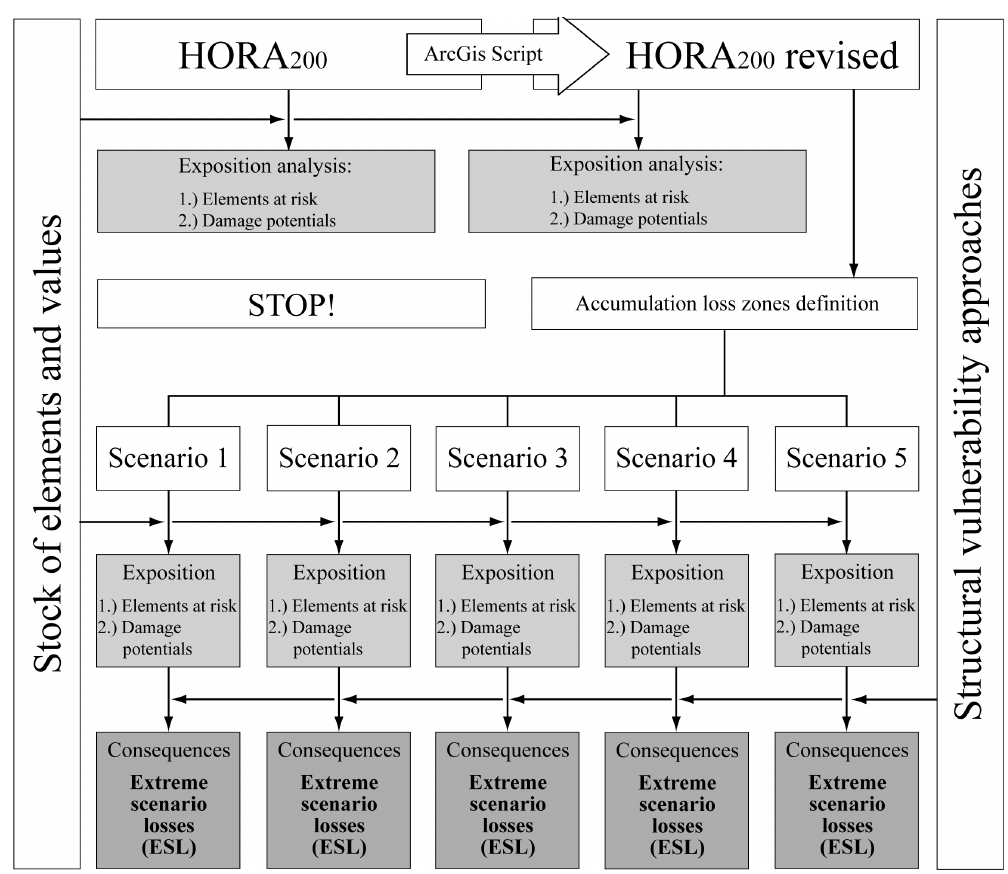
Fig. 1. Overview of the study concept: procedures (i) to analyse the exposures within the general HORA 200 flood hazard areas in Tyrol and (ii) to analyse the exposures and the consequences based on the defined extreme flood scenarios. The stock of elements and values forms the fundamental basis to identify exposed elements whereas the specific loss consequences are dependent on the applied structural vulnerability